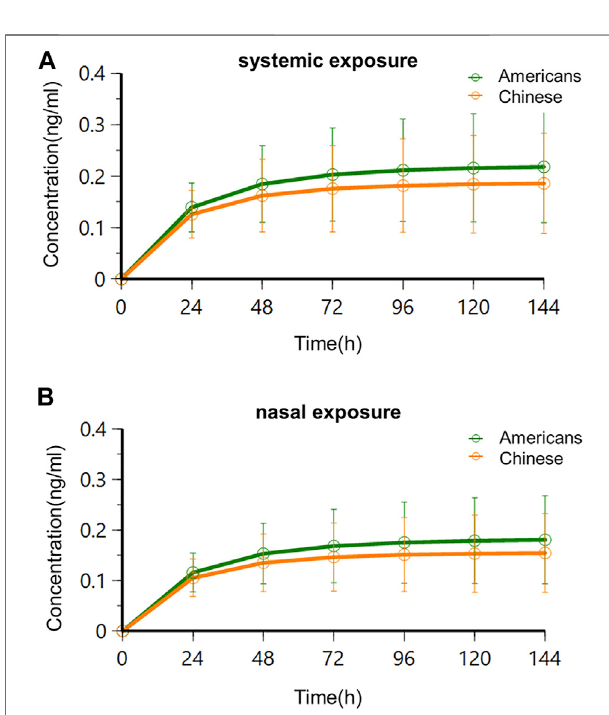
FIGURE 8 | Trough concentration – time curves in Americans and Chinese following multidose administration. (A) Systemic exposure; (B) nasal